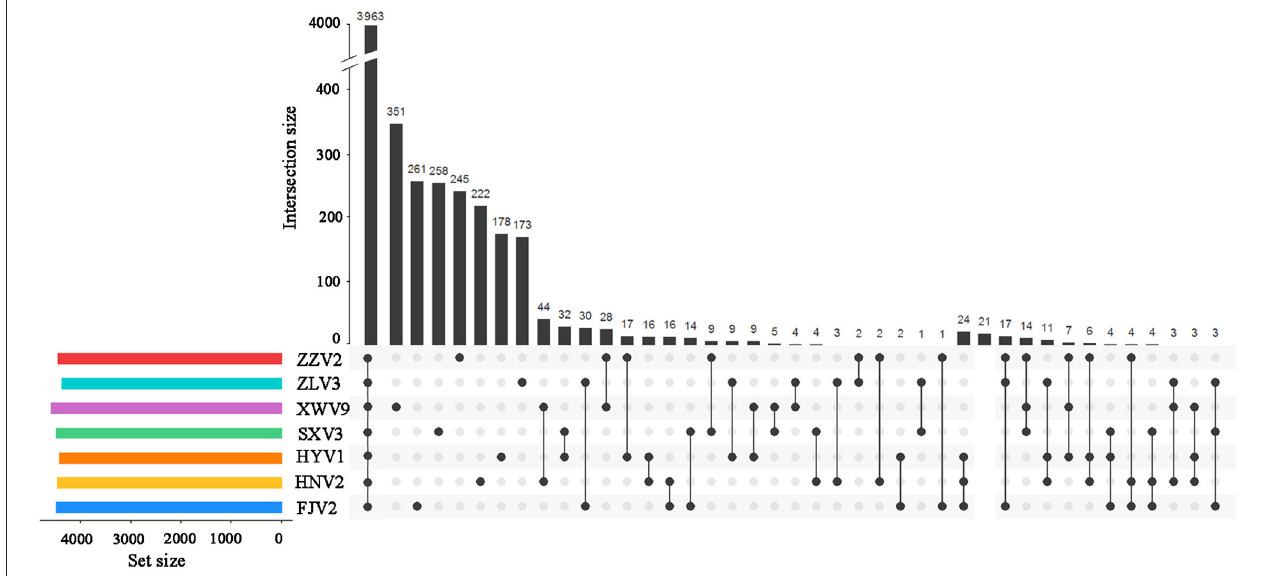
FIGURE 4 | UpSet plot of the intersection of gene clusters in the seven V. alginolyticus strains. The numbers of gene clusters in the core, specific, and intersecting genomes in two or three strains are indicated.